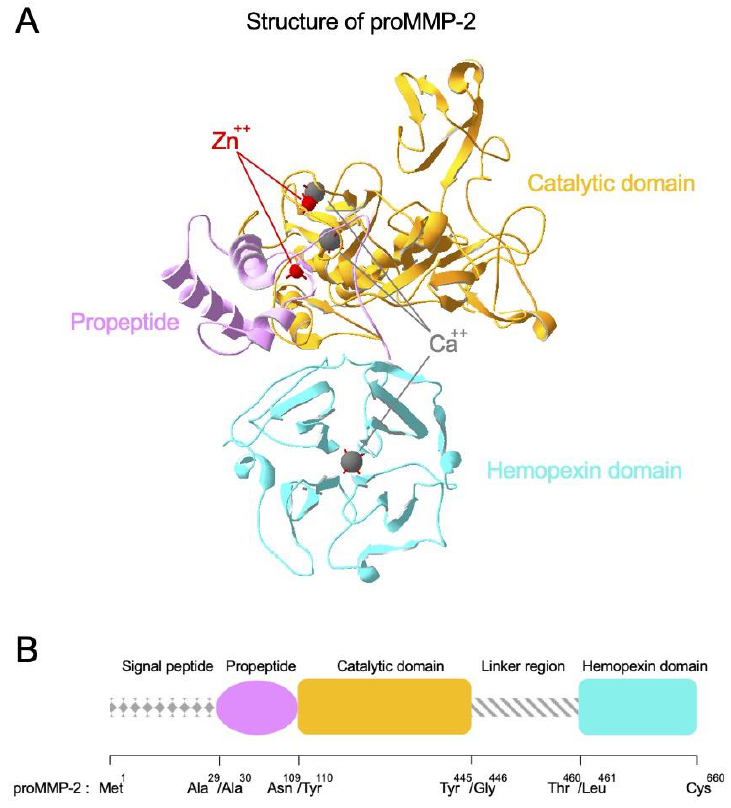
Figure 2. Structure and domain organization of proMMP-2. ( A ) Structure of proMMP-2 is presented as an example of MMP structure. proMMP-2 is composed of functionally distinct domains. The catalytic domain, propeptide and hemopexin domain are described in orange, pink and cyan color, respectively. Zn ++ and Ca ++ ions are indicated by red and gray color, respectively. Illustration is based on the crystal structure (PDB accession number: 1CK7). ( B ) Domain organization of proMMP-2 is presented as a representative example of MMP domain organization. Table 1. Classification of major MMPs and their substrate specificity for ECM components.